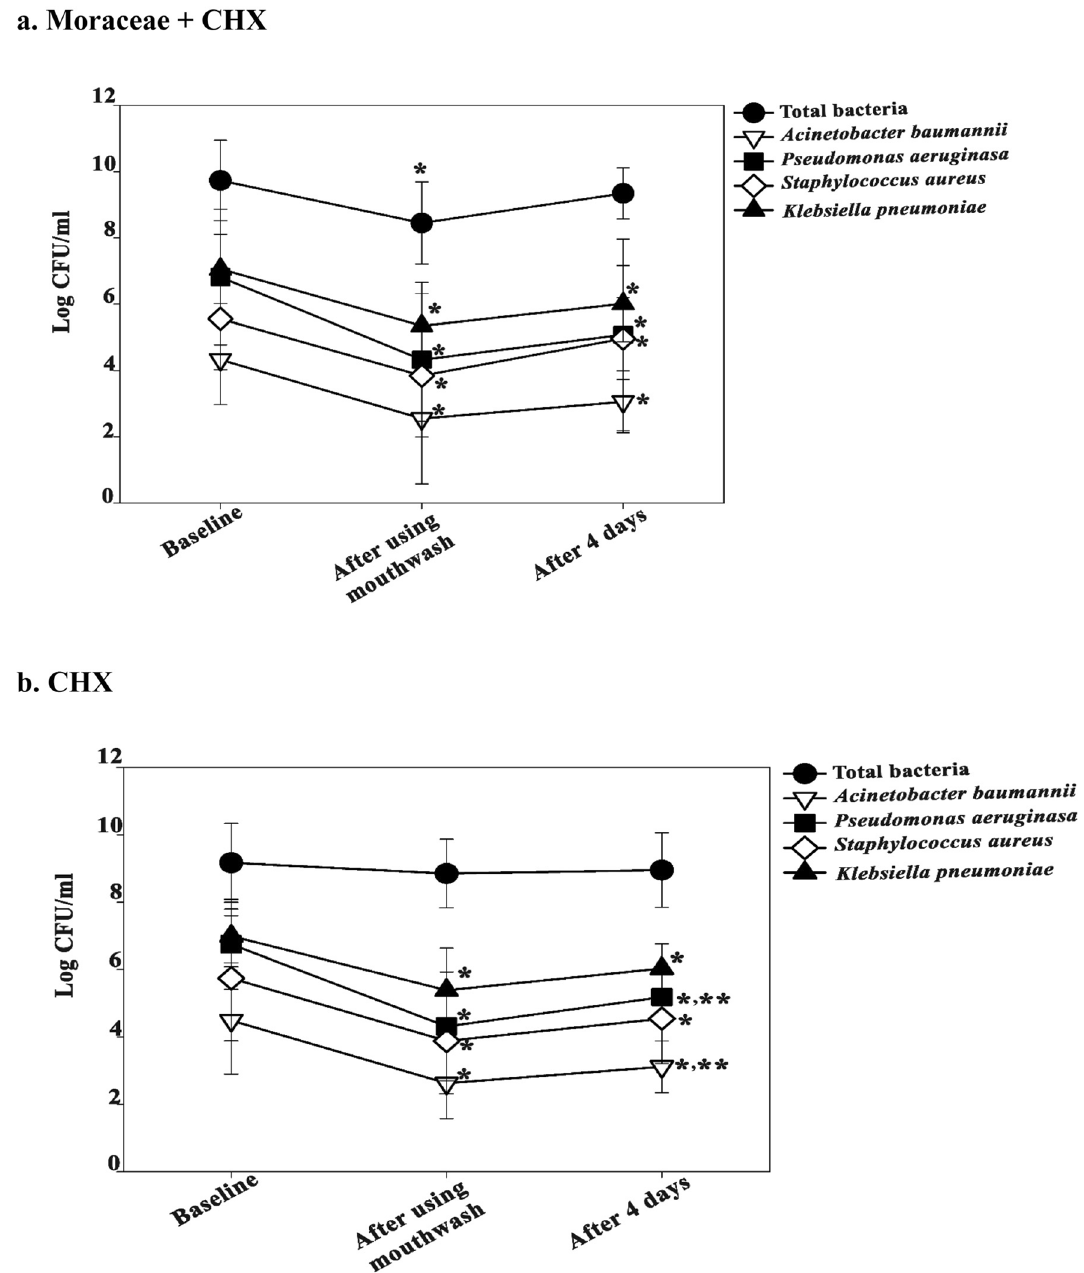
Figure 2. Bacterial counts in the mouthwash-treated patients’ saliva at the baseline, immediately after, and on day 4 a . Moraceae with CHX group b . CHX group. * Statistically significant difference between T0 and T1 or T2 ( P < 0.01). ** Statistically significant difference between T1 and T2 ( P < 0.01). CHX, chlorhexidine; T0, baseline; T1, after using mouthwash; T2, after 4